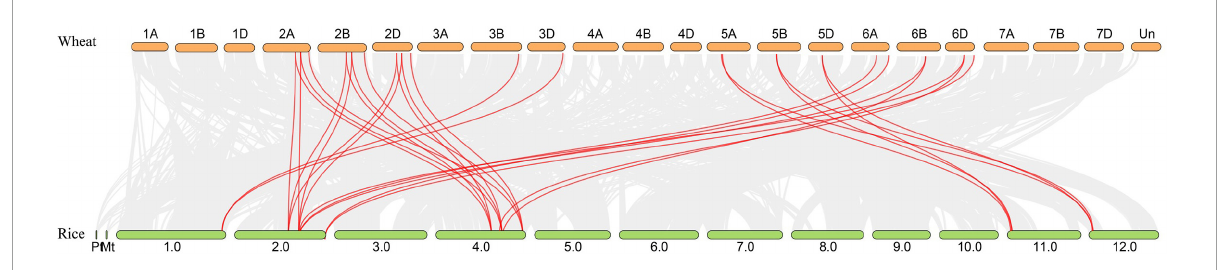
FIGURE4 Synteny analysis of RRA genes in wheat and rice. Gray lines in the background indicate all syntenic blocks within the two genomes, while red lines highlight the syntenic RRA gene pairs.